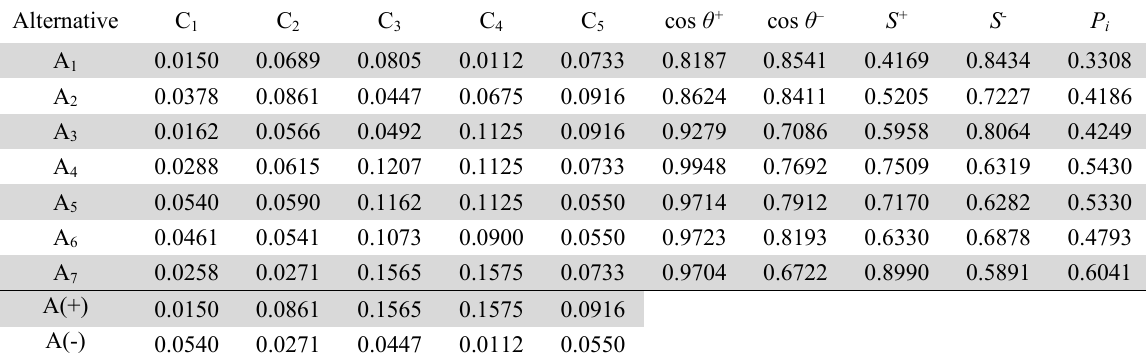
Weighted normalized matrix for neat oil selection